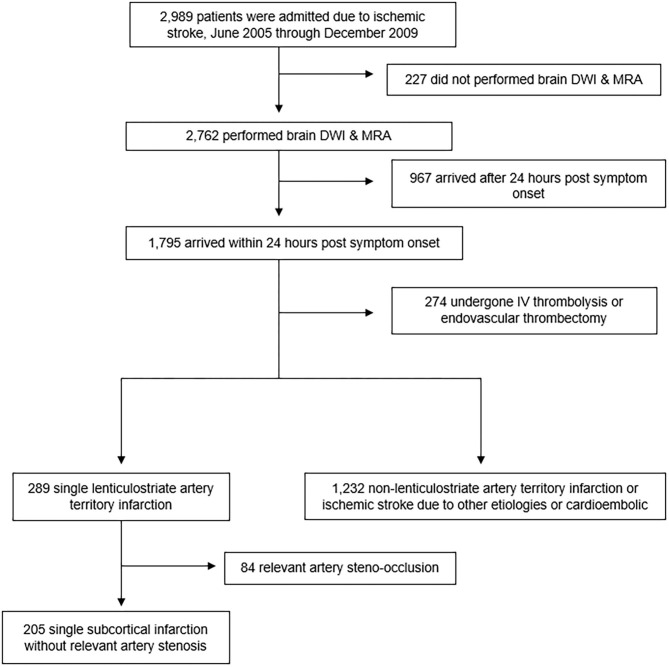
Study Flowchart. DWI, diffusion-weighted imaging; MRA, magnetic resonance angiography.